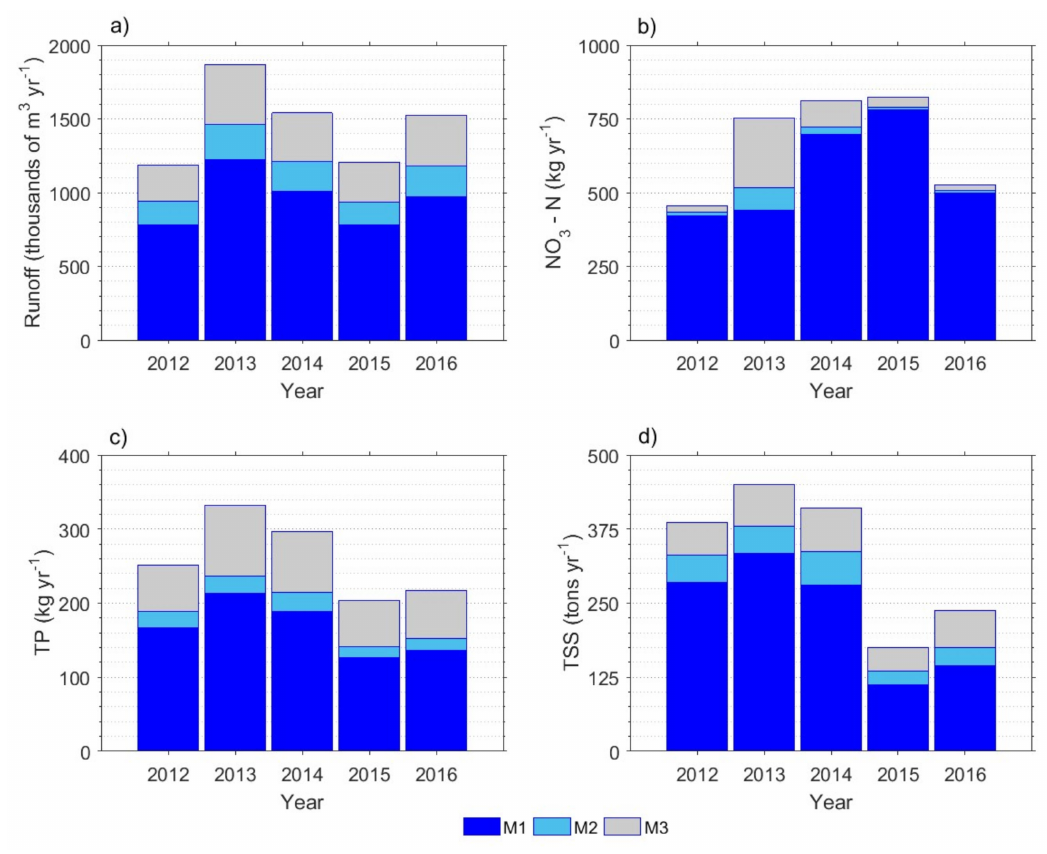
Figure 7. Comparison of ( a ) the total annual runo ff production, ( b ) the total annual NO 3 –N load, ( c ) the total phosphorus (TP) load, ( d ) and the total suspended solids (TSS) in the simulated watershed. M1: TWR inlet; M2: TWR mid-canal; M3: TWR